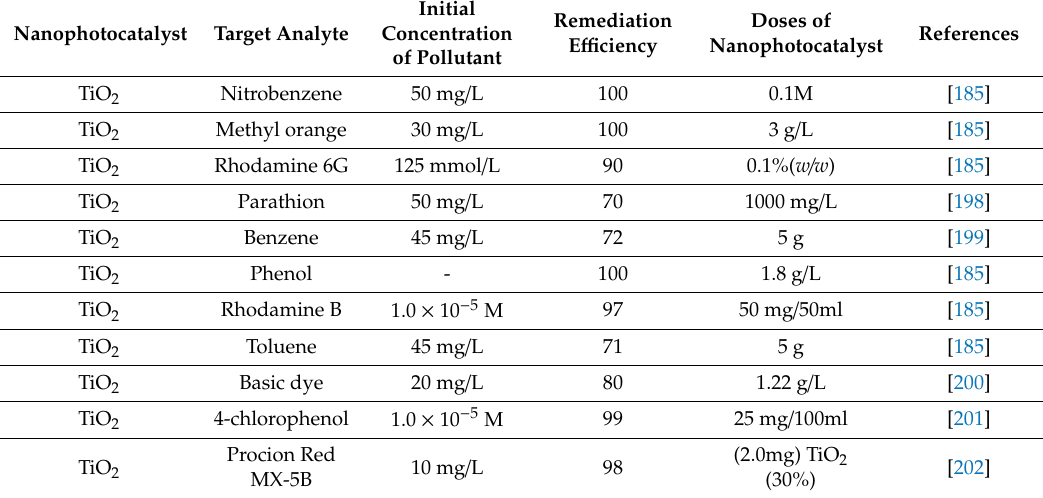
Table 8. Observation of di ff erent pollutant removal by TiO 2 nanophotocatalyst. Nanophotocatalyst